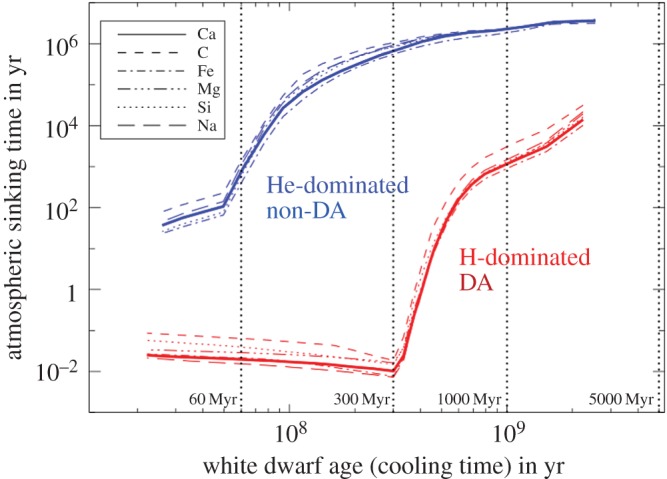
Cosmetically enhanced version of fig. 1 of [98]. Shown are the sinking times of six metals in WD atmospheres. These times are orders of magnitude less than the WD cooling ages. The sinking timescales of DA WDs younger than about 300 Myr are days to weeks.